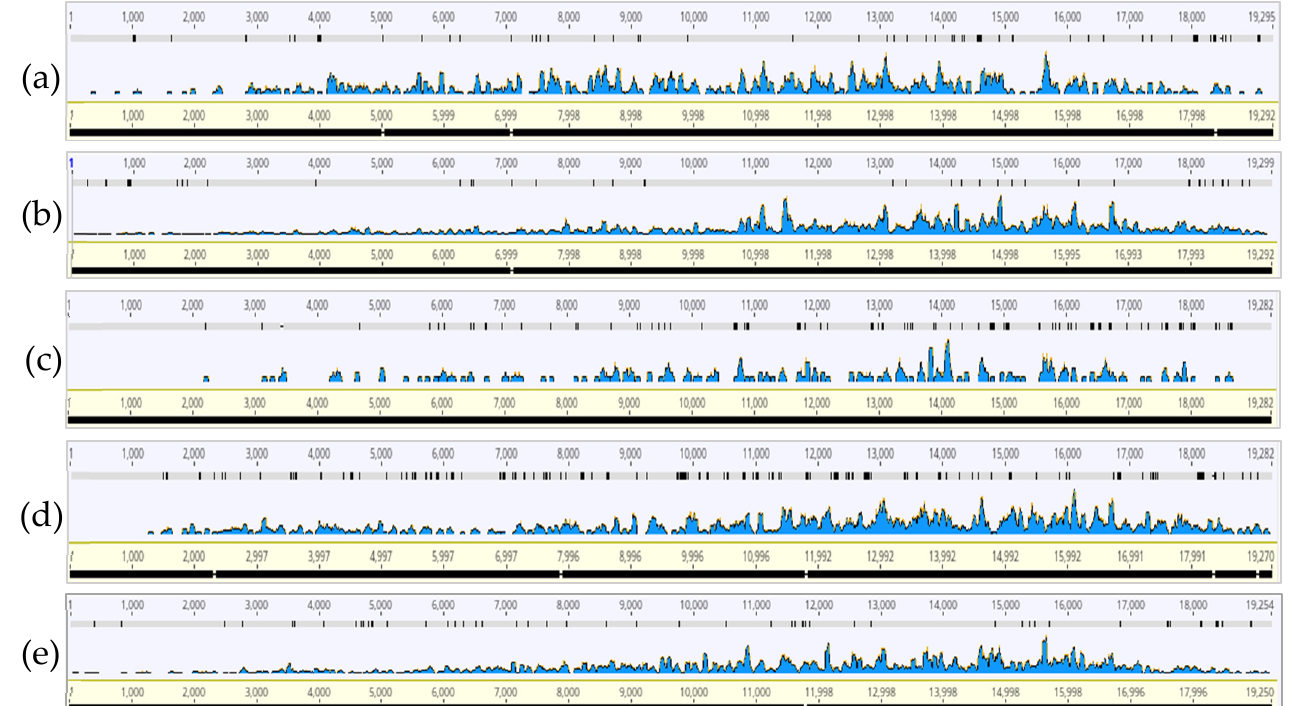
Figure 2. Read coverage and distribution profile generated from each Florida Region of 2020 aligned to the respective citrus tristeza virus (CTV). ( a ) Region A (CTV T36, KC517485.1); ( b ) Region B (CTV